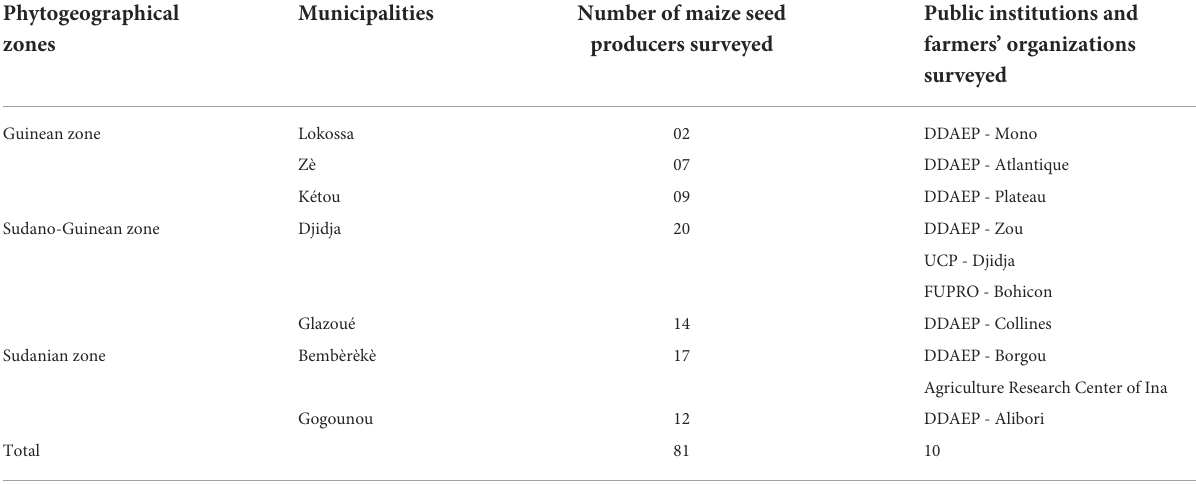
TABLE 1 Stakeholders surveyed in each municipality per phytogeographical zone in Benin.